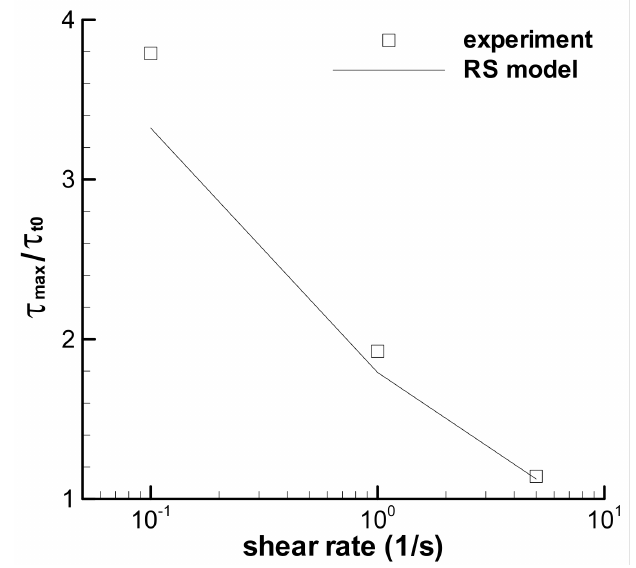
Figure 11. Ratios of the maximum shear stress over the stress at t 0 = 1 s for three trapezoidal loops with t 0 = 1 s. Symbol is the experimental data [35], and line is the calculation. The subscript t 0 denotes the beginning time of the constant shear-rate region, i.e., t 0